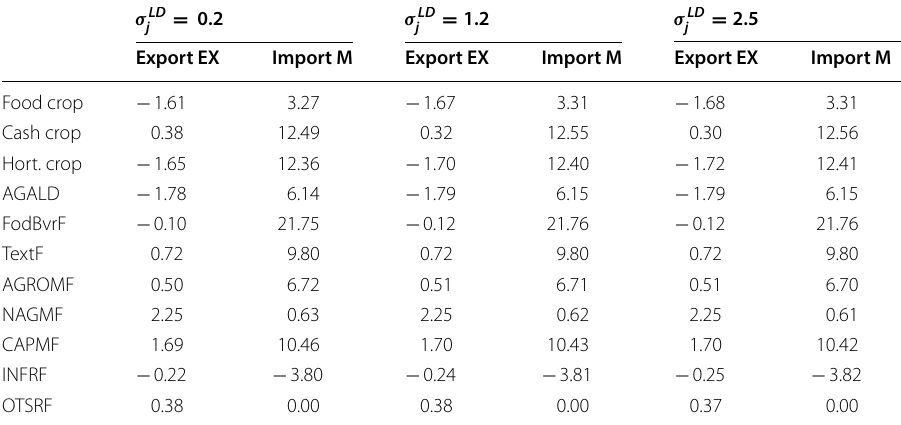
Table 2 (Scenario A1: S1–S3) Change (%) in export–import due to 50% tariff reduction (segmented labour